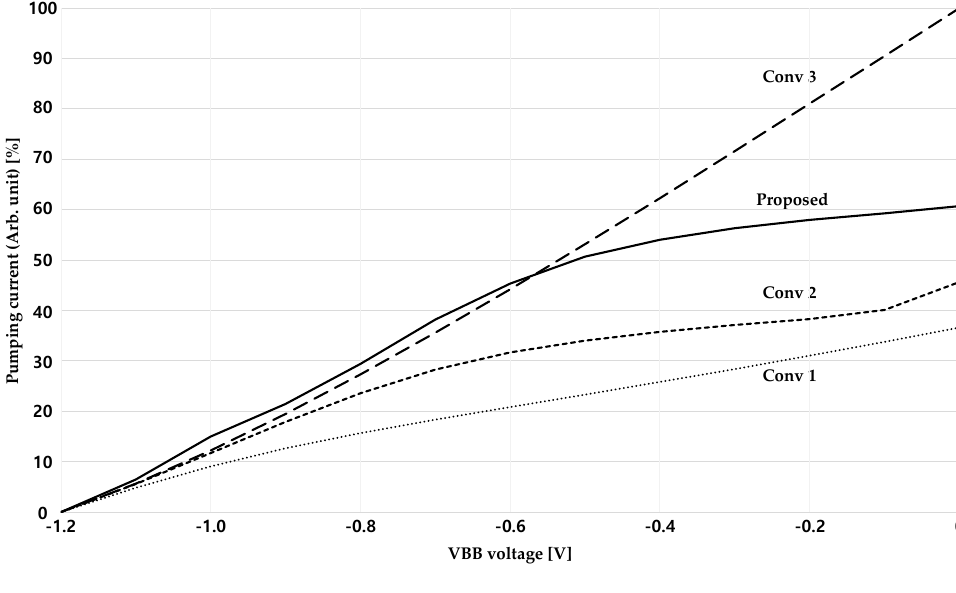
Figure 8. Pumping current.